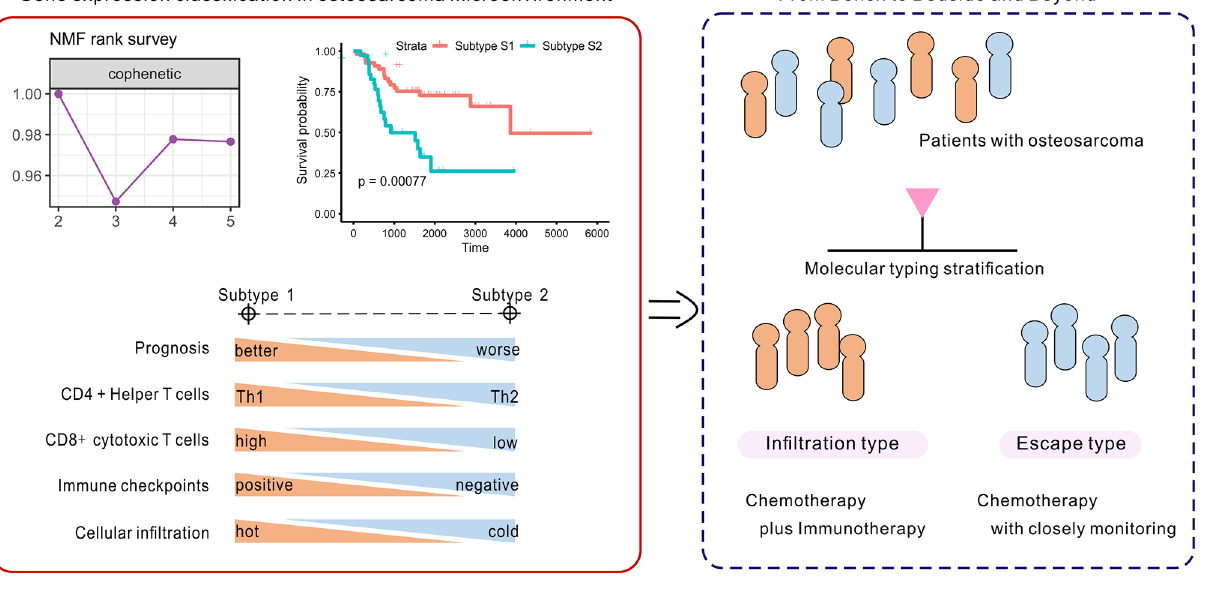
FIGURE 8 | Identi fi cation and development of the gene-based classi fi cation system toward precision medicine in